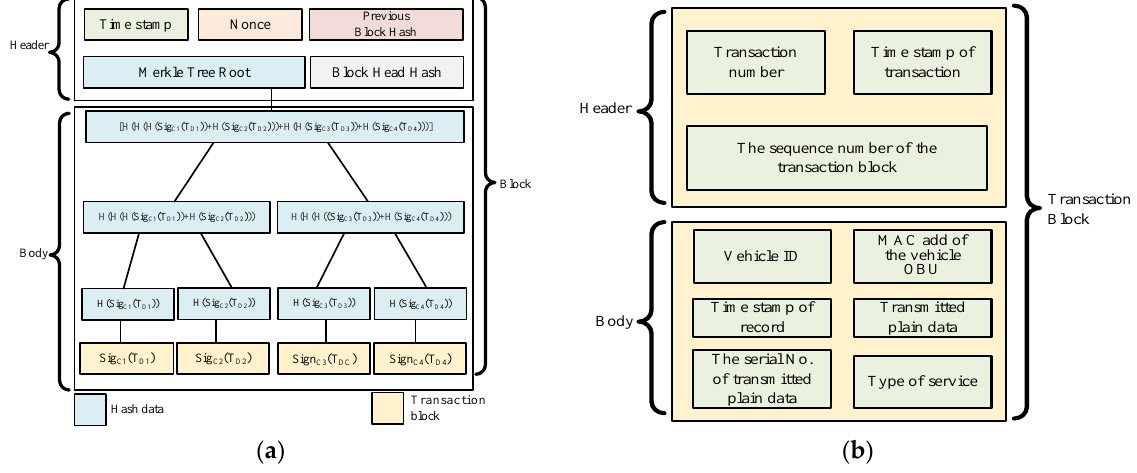
Figure 1. The detailed structure of the block. ( a ) The transitional block. ( b ) The proposed transaction block.